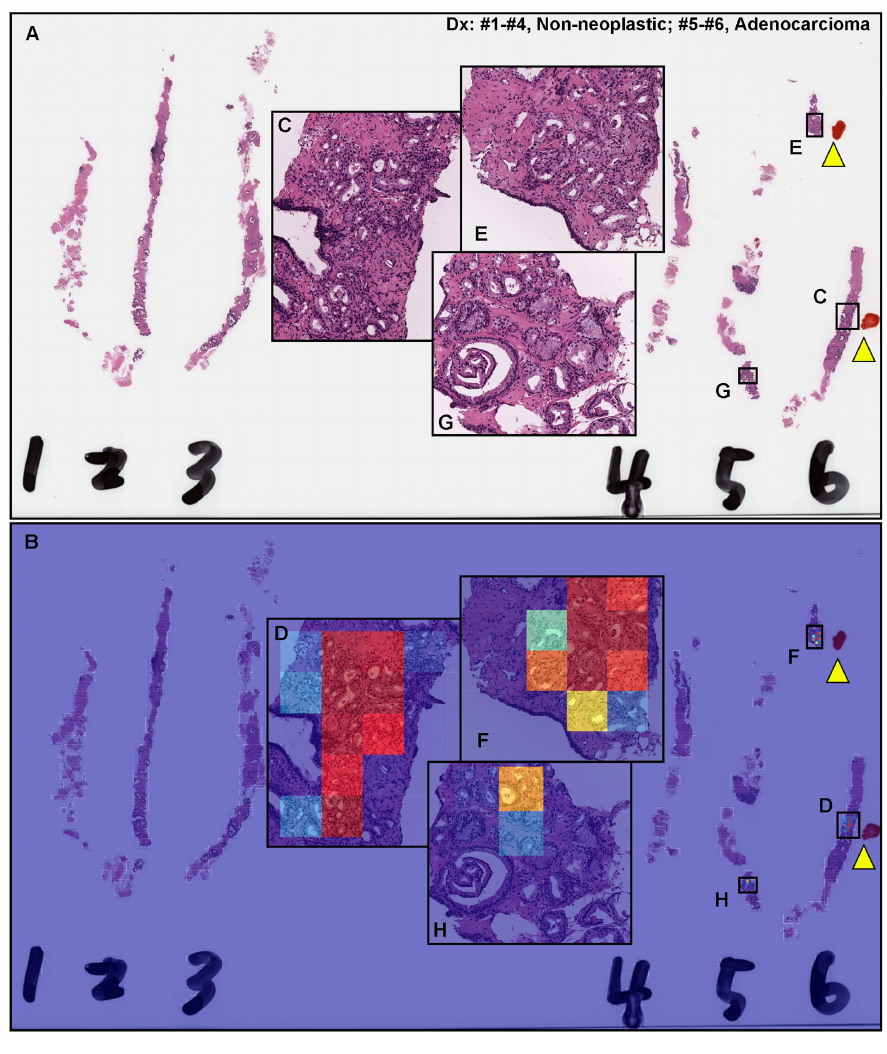
Figure 3. Representative true positive prostate adenocarcinoma from the biopsy test sets. On the prostate needle biopsy whole-slide image ( A ), Specimens #1–#4 are benign (non-neoplastic), and there are adenocarcinoma cell infiltration foci ( C , E , G ) in Specimens #5 and #6 based on the pathological diagnostic report, which the pathologists marked as red ink dots (yellow triangles) on the glass slides. The heat map image ( B ) shows the true positive prediction of adenocarcinoma cells ( D , F , H ) using transfer learning from the colon poorly differentiated adenocarcinoma model (TL-colon poorly ADC-2 (20 × , 512)), which corresponds respectively to the H&E histopathology ( C , E , G ). The heat map uses the jet color map where blue indicates low probability and red indicates high